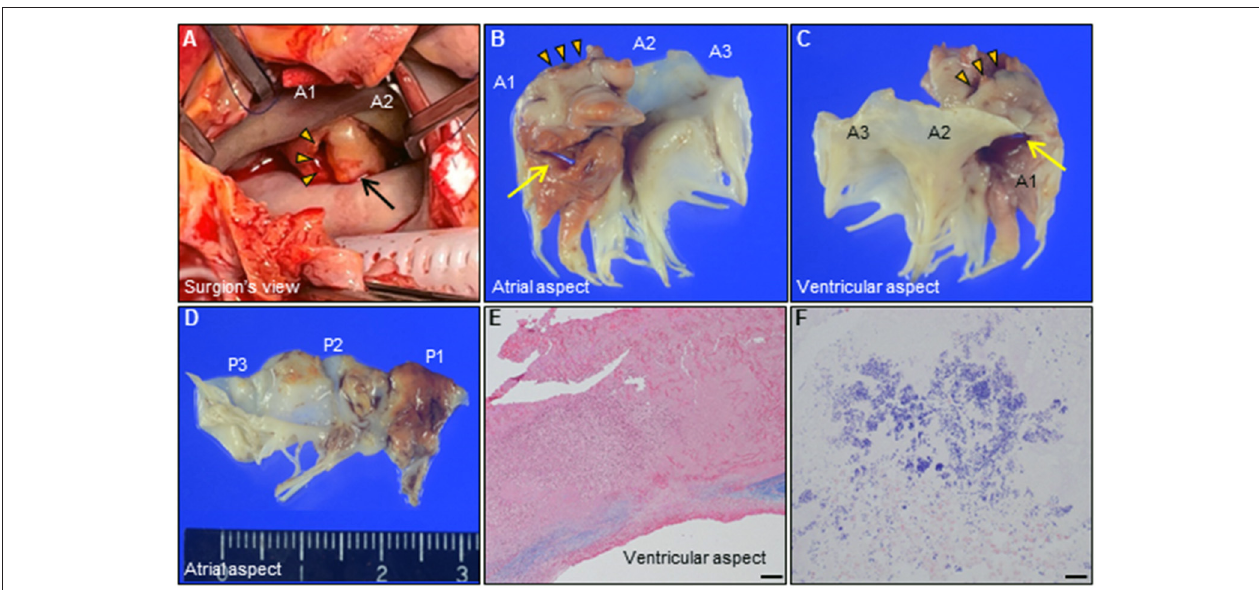
FIGURE 3 | (A) Intraoperative photograph of the mitral valve. Giant MVA (arrow, 28 × 23 × 12mm) with ruptured perforation (arrowheads) is observed on the AML in A1. (B–D) Representative photographs of the extracted mitral valve leaflets [ (B,C) , AML; (D) , PML]. Note the two distinct perforations through the MVA (arrow, arrowheads, respectively). (E,F) Histological findings of the resected MVA shows extensive valvular destruction with a high degree of neutrophilic inflammatory cell infiltration and bacterial agglomeration. [ (E) , Elastica van Gieson staining, Bar 200 µ m; (F) , Gram staining, 20 µ m]. AML, anterior mitral leaflet; MVA, mitral valve aneurysm; PML, posterior mitral